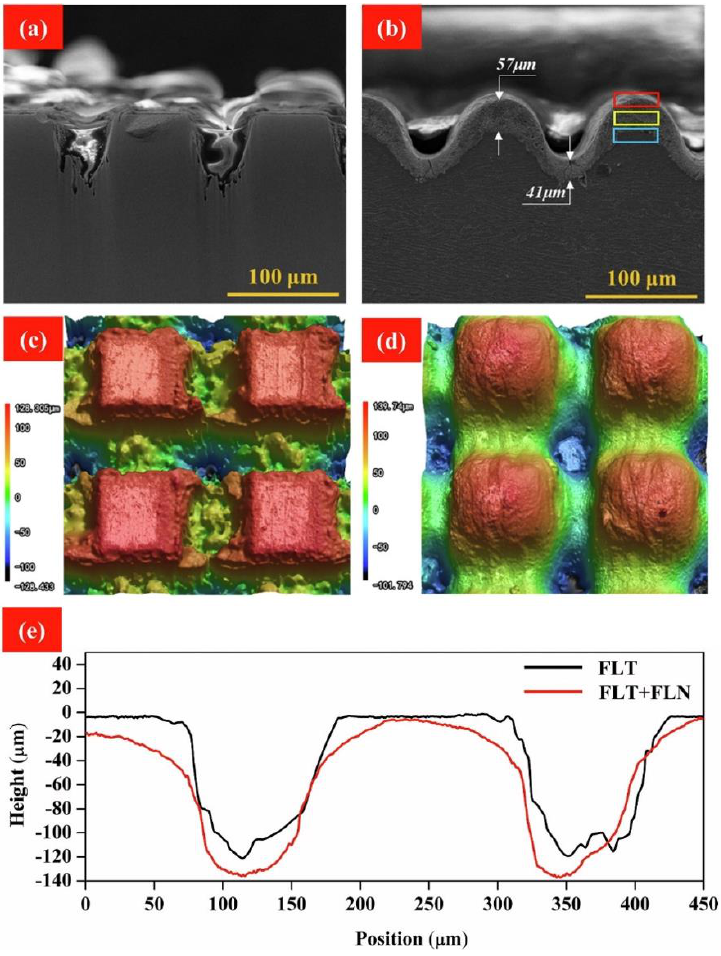
Figure 7. Ref. [71] The surface morphology and cross-section microstructure of the samples pro − cessed by Femtosecond laser texturing (FLT) and FLT+Femtosecond laser nitriding (FLN); ( a ) SEM image of FLT, ( b ) SEM image of FLT+FLN, ( c ) 3D morphology of the cross-section of FLT, ( d ) 3D morphology of the cross-section of FLT+FLN, ( e ) Profile curves corresponding to ( c , d